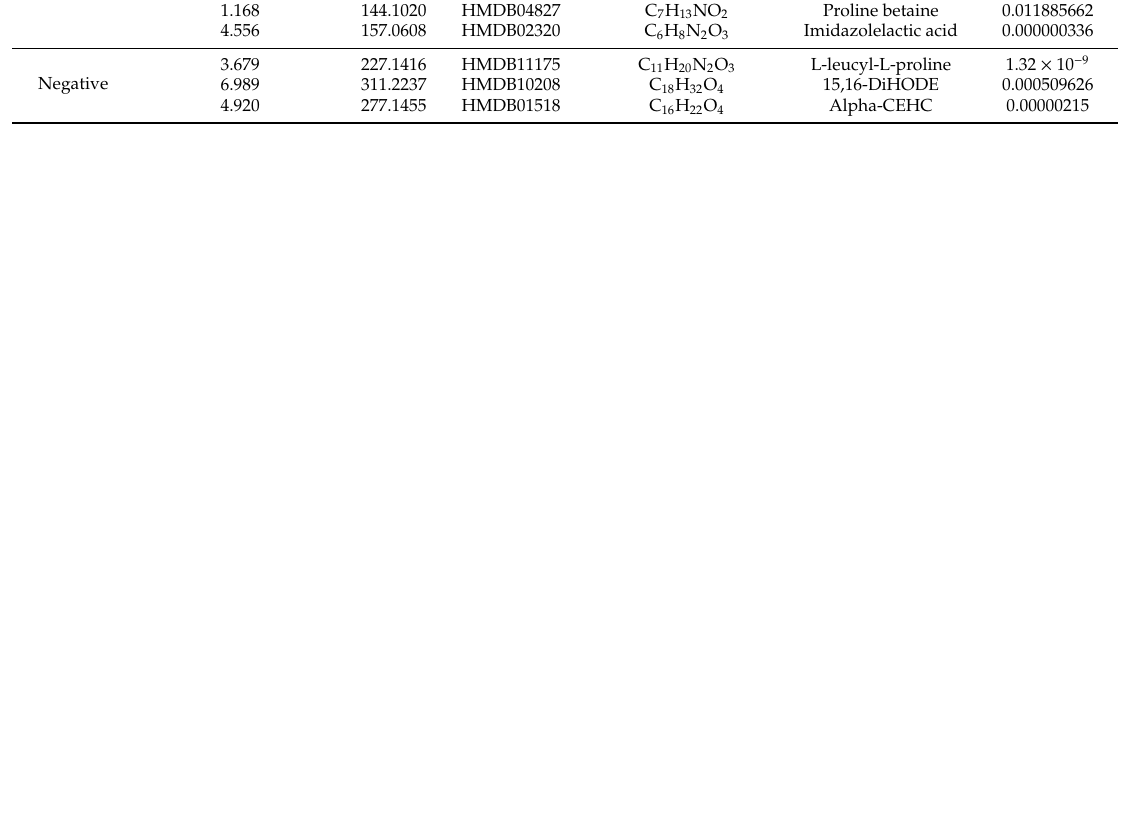
Table 1. Preliminary identification results of endogenous metabolites in plasma of rats in each group.